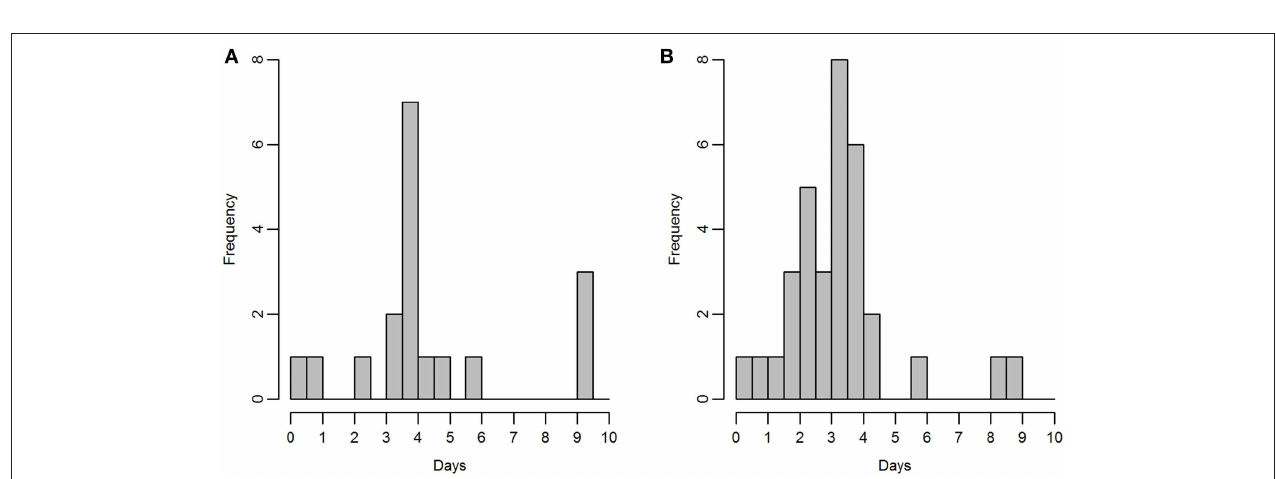
FIGURE 2 | Duration of time for which tags were active, for (A) guillemot and (B) razorbill; bins represent half days.